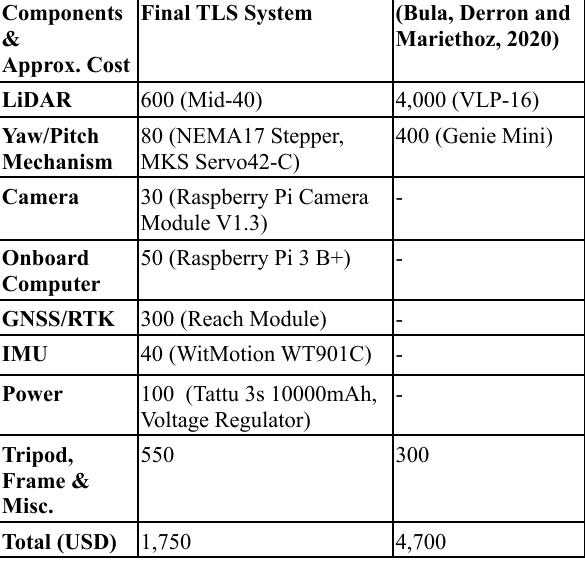
Table 1. Cost breakdown and comparison